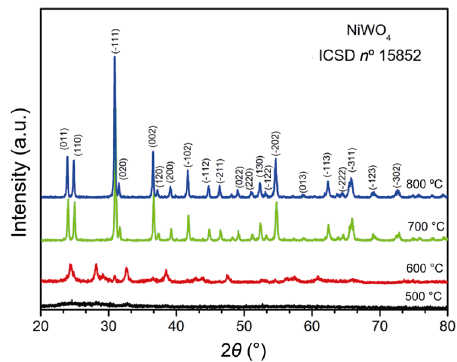
Fig. 2 XRD patterns of NiWO 4 powders after annealing at 500, 600, 700, and 800 ℃ for 2